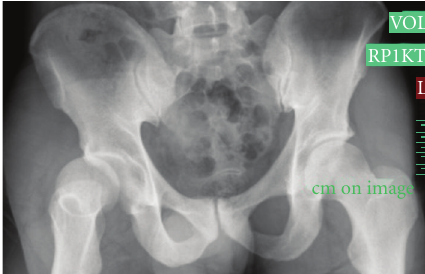
Figure 1: Plain radiograph of the pelvis shows a dislocated right hip.